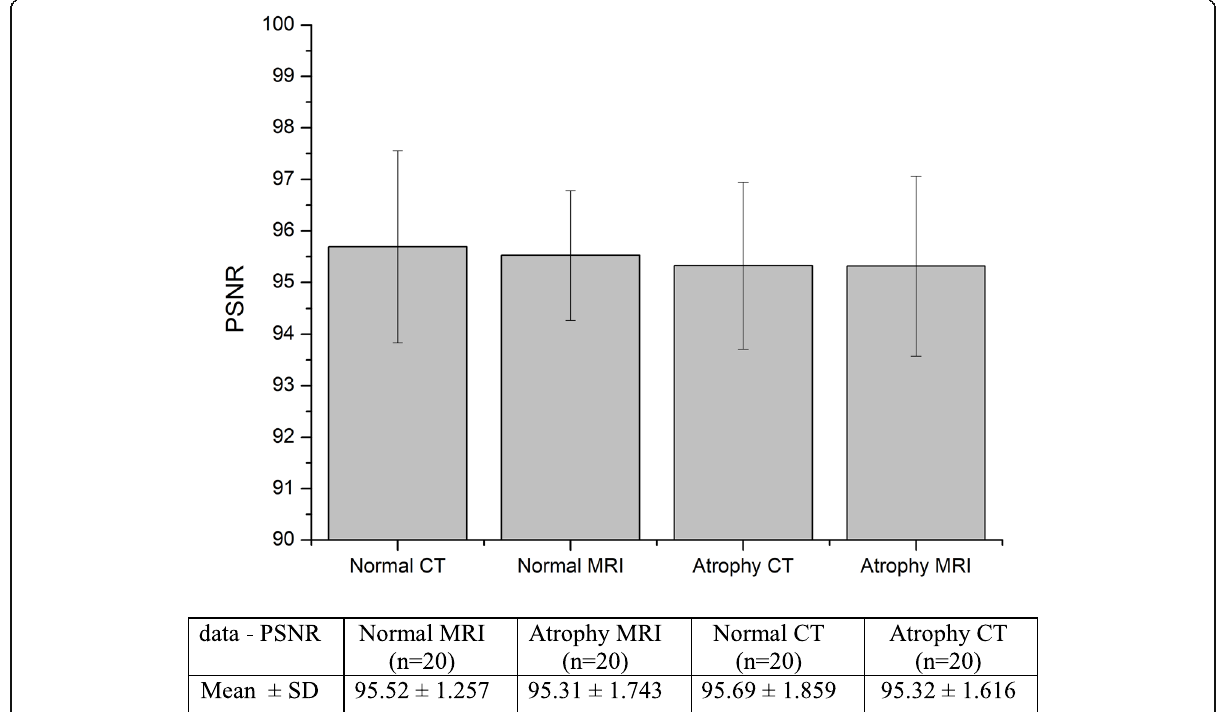
Fig. 9 Results of PSNR calculated between ground truth and segmented images for CT and MR datasets